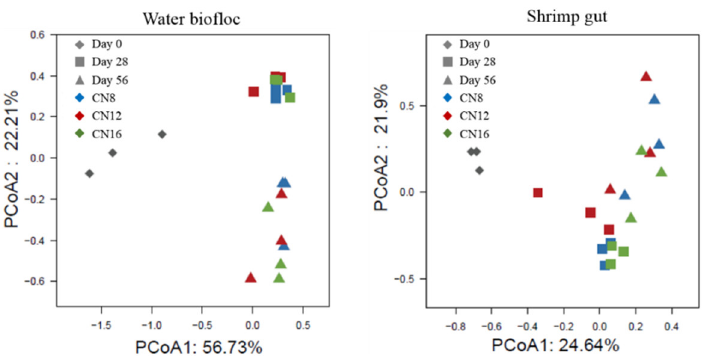
Figure 5. The differences in bacterial community structure in water biofloc and shrimp gut from biofloc-based tank systems during an 8-week intensive production trial of P. vannamei with three input C/N ratios, identified by principal coordinates analysis (n = 3).